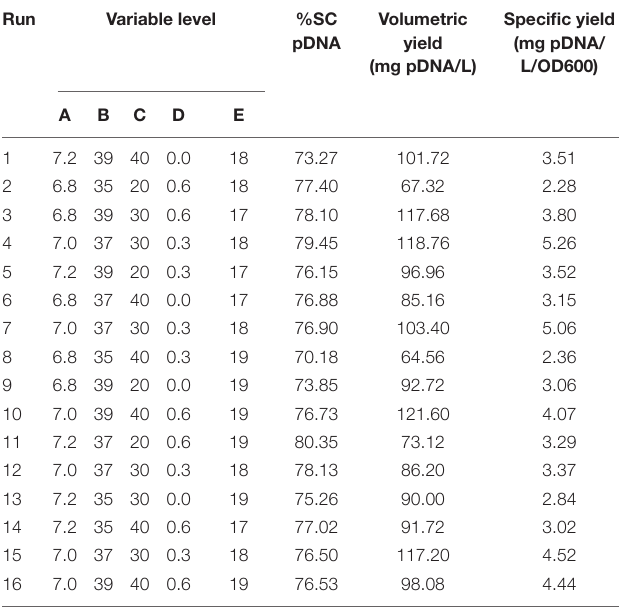
TABLE 2 | Definitive-screening design (DSD) and experimental data responses.